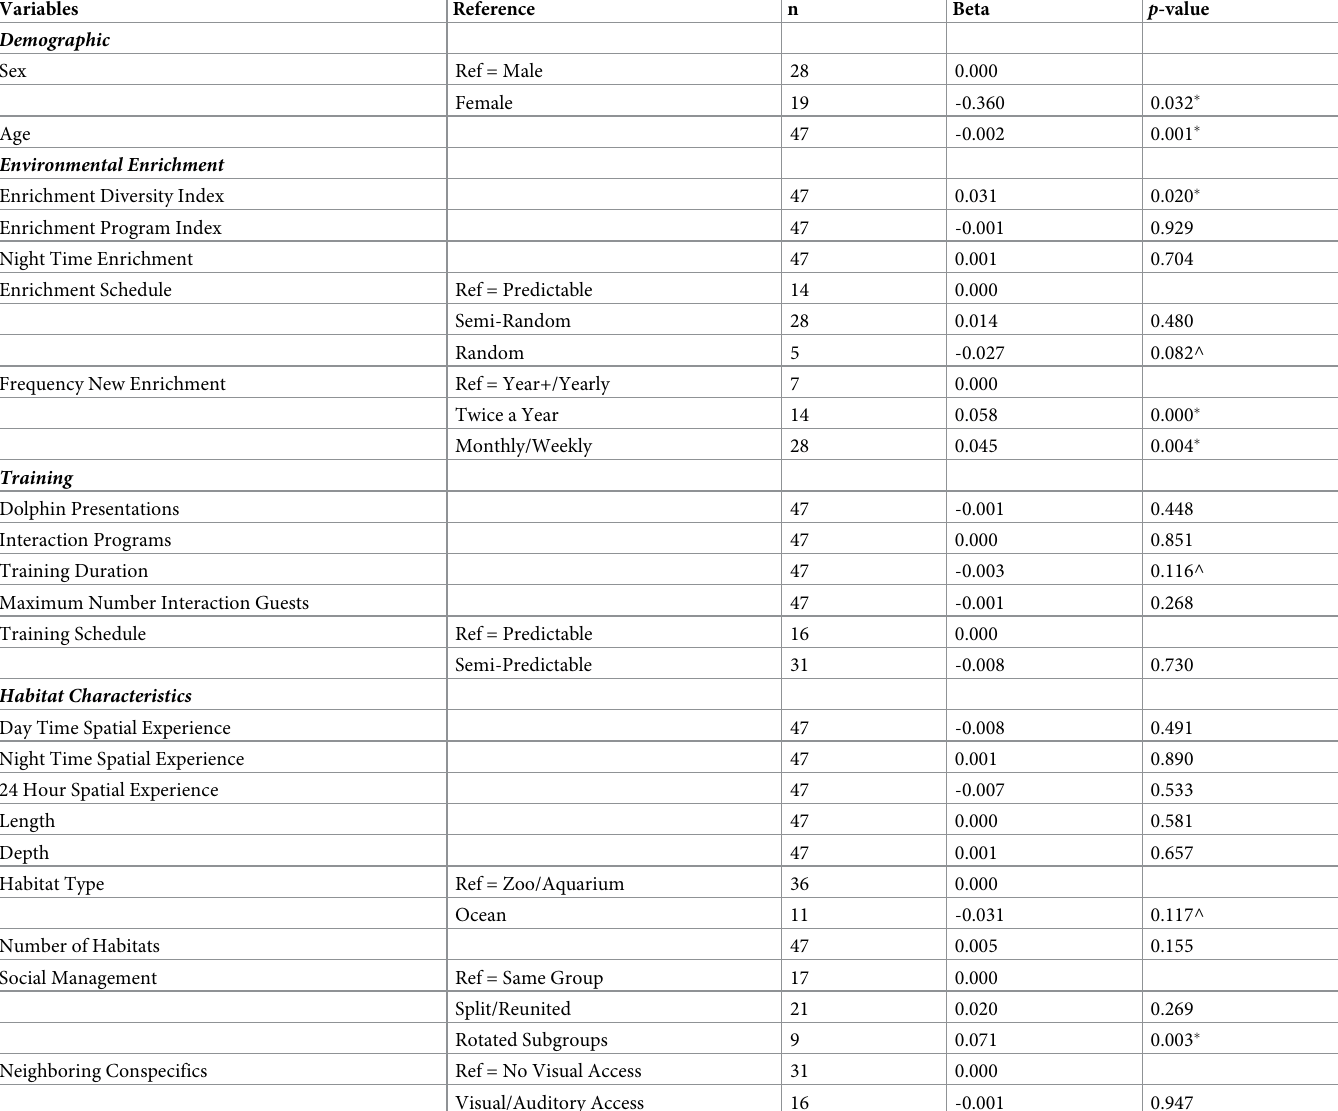
Table 4. Summary of univariate analysis for relationships between independent variables and group active